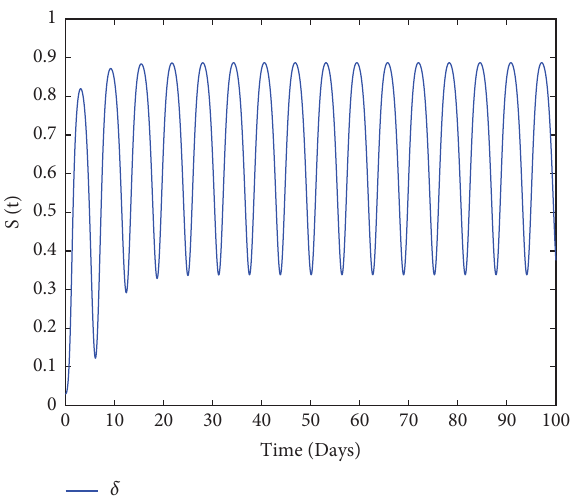
Figure 4: When δ changes over time, the density changes the curve of S